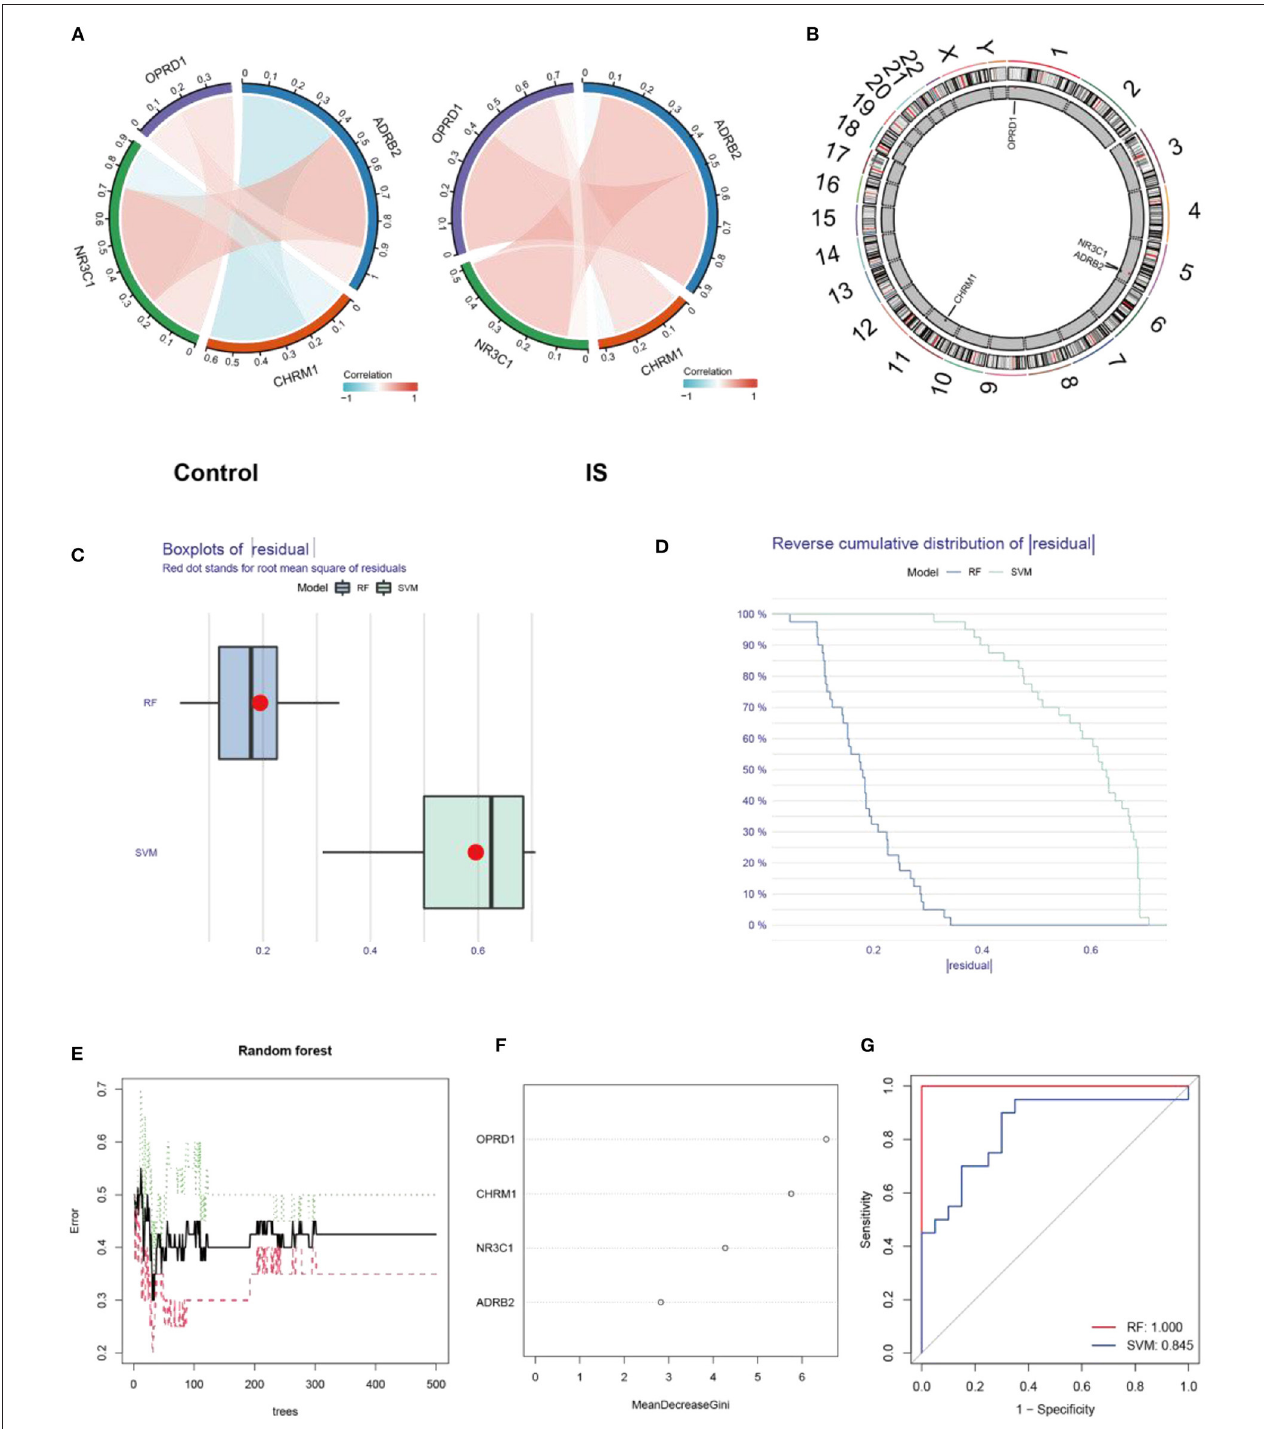
FIGURE 6 | Expression characterization and predictive power analysis of CHRM1, NR3C1, ADRB2, and OPRD1. Correlation analysis of CHRM1, NR3C1, ADRB2, and OPRD1 in the GSE22255 dataset in the control and IS groups, with red indicating positive correlation and blue indicating negative correlation (A) ; The positions of the four genes CHRM1, NR3C1, ADRB2, and OPRD1 in the chromosome are shown in a circular diagram (B) ; Boxplot of “residuals” in RF and SVM models (C) ; Cumulative distribution characteristics of “residuals” in RF and SVM models (D) ; The variation of error in the random forest model with the number of “trees” included in the model (E) ; The genes are ranked according to their importance (F) ; ROC curves reflecting the predictive power of RF and SVM models (G) .